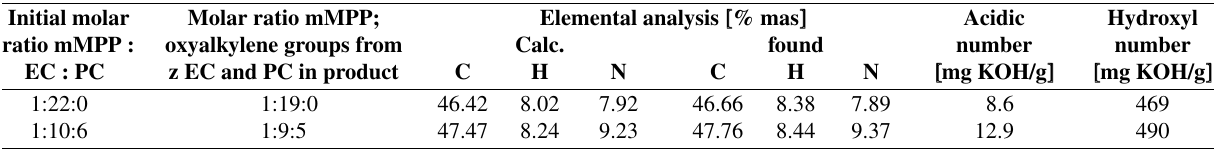
Table 2. Elemental analyses, acid and hydroxyl numbers of obtained oligoetherols Initial molar Molar ratio mMPP; Elemental analysis [[ % mas ]] Acidic ratio mMPP : oxyalkylene groups from